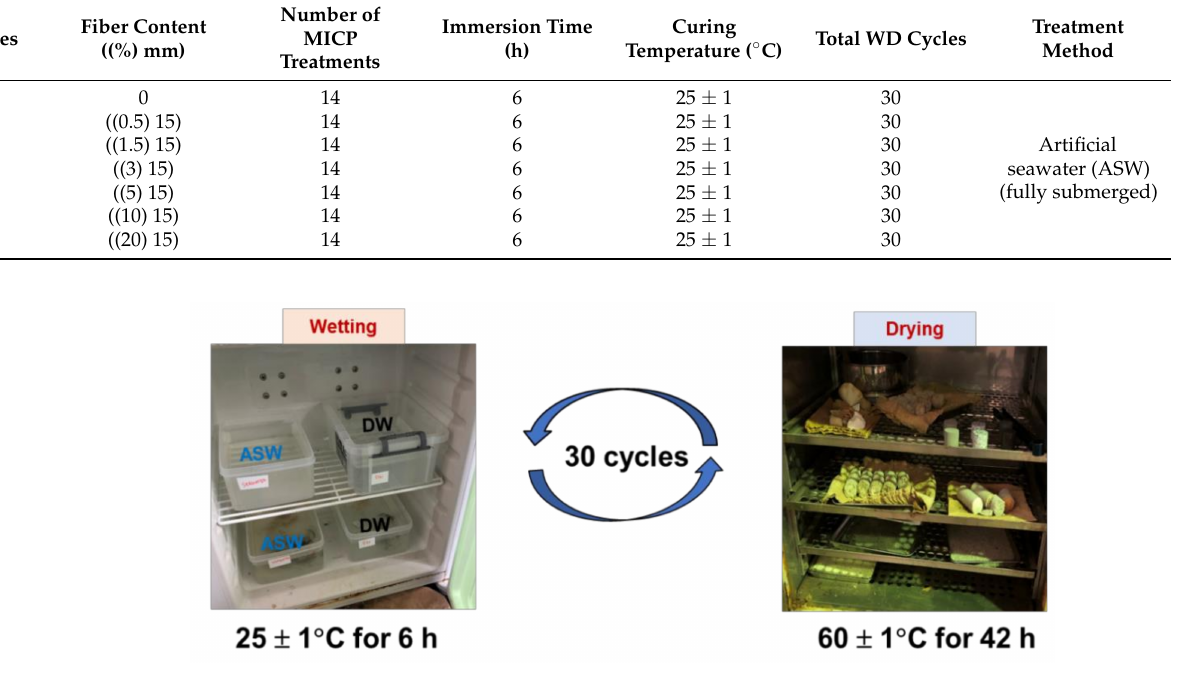
Figure 3. Cyclic wet–dry testing procedure used in this